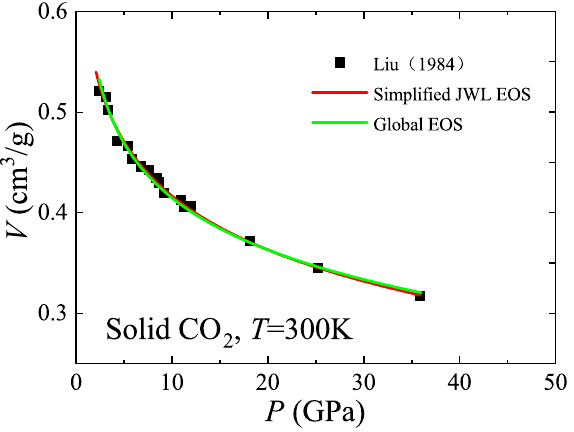
Figure 4. Comparison of the global P-V-T EOS with the simplified JWL EOS using solid CO 2 data.